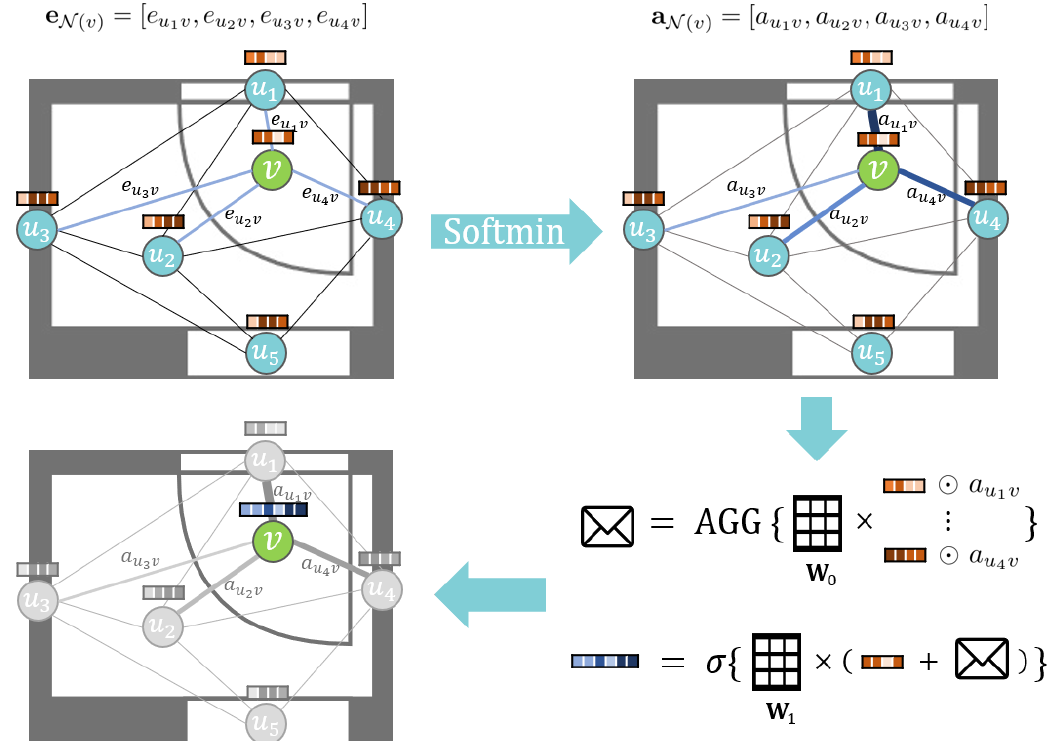
Figure 4. Visual illustration of the update process of node v (a door segment). The softmin function assigns respective attention values to each neighbor of v according to their distance to v ( e u ). Each node’s embedding vector at layer k − 1 i v is element-wise multiplied with a respective attention value. They pass through a weight matrix W 0 and aggregated to a message. This message is added to v ’s embedding vector at layer k − 1 and multiplied with the weight matrix W 1 . The result is the embedding vector of node v at layer k . In the Figure, a N ( v ) is the converted attention vector and AGG is the AGGREGATE